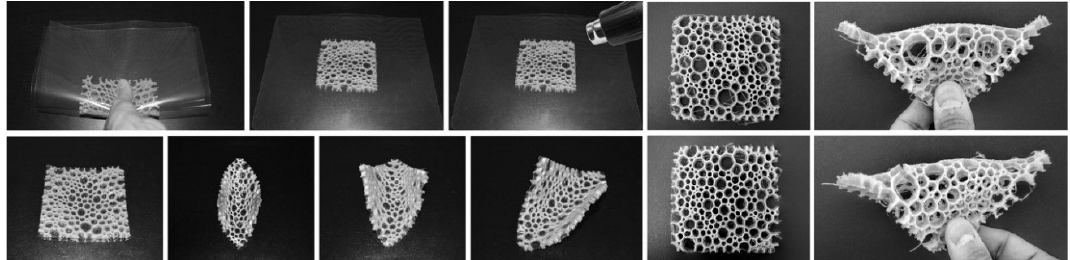
Figure 7. Dragonfly-inspired structure that creates a sandwich effect by wrapping a 3D-printed core made from semi-flex TPU filament between two layers of PETG plastic sheets.